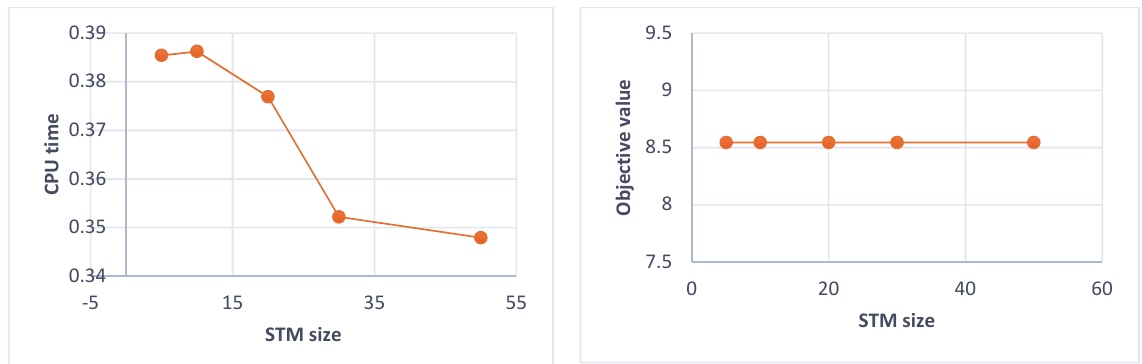
Fig. 7. The effect of the coolest temperature on the CPU time